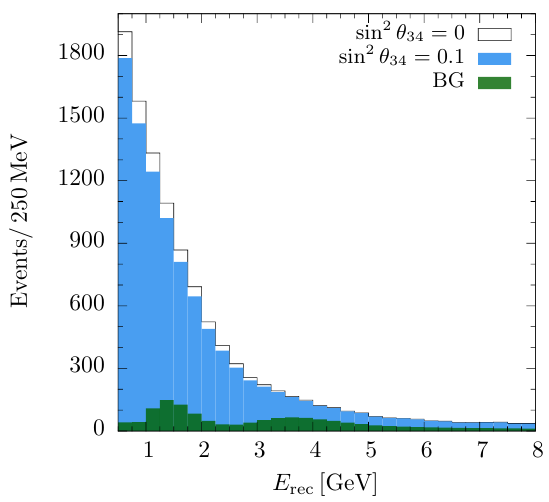
Figure 2 . Expected signal and background event distributions, as a function of the reconstructed visible energy, after e(cid:14)ciencies and detector reconstruction. The white histogram shows the ex- pected number of NC events in the 3-family standard scenario, while the blue (light gray) histogram shows the expected number of NC events for sin 2 (cid:18) 34 = 0 : 1, (cid:18) 14 = (cid:18) 24 = 0. The expected